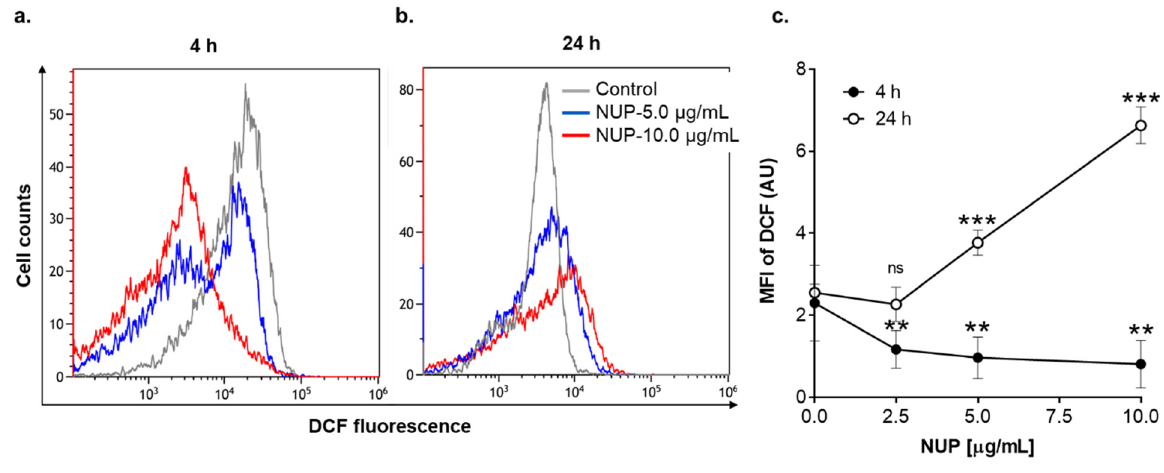
Figure 4. NUP induces time-dependent biphasic changes in the cytosolic levels of reactive oxygen species as well as a decrease in GSH levels after a longer treatment. Following incubation with vehicle or indicated concentrations of NUP, HL60 cells were loaded with DCFH-DA followed by flow cytometric analysis, as described in Materials and Methods. ( a , b ) Typical examples of cytosolic ROS measurement at the indicated time points. ( c ) Averaged relative ROS levels expressed by DCF geometric mean fluorescence intensity (MFI) units, as determined after 4 h and 24 h of incubation; the data are means ± SD of 3 independent experiments performed in duplicate. **, p < 0.01 and ***, p < 0.001 vs. vehicle-treated (control) cells; ns, non-significant.